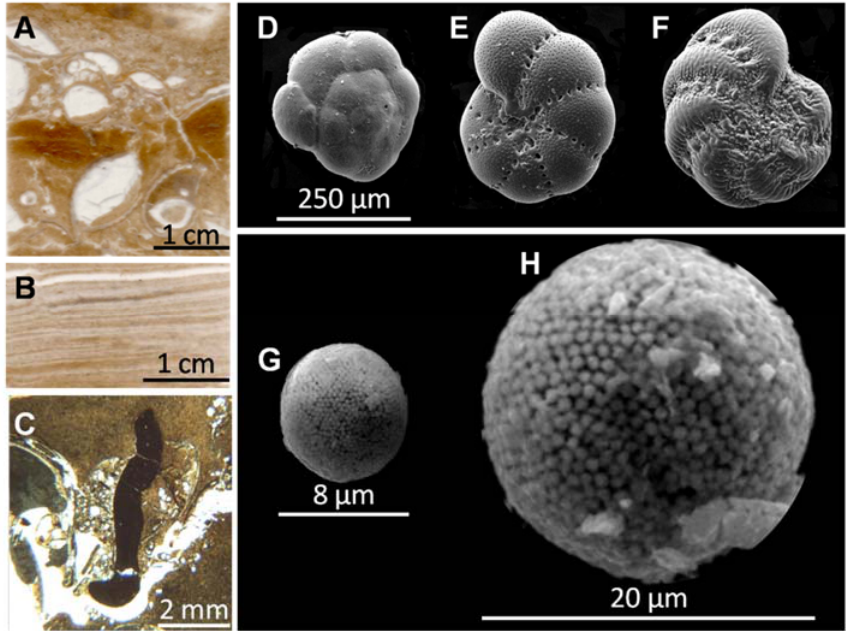
Figure 4. Illustrations of elements encountered in the studied cores. Sedimentary structures observed in thin section by optic microscope (see vertical positions in the cores in Figure 3): ( A ) tempestite at the top of Unit 8 in GC7; ( B ) laminations between 169 and 171 cm in GC7 (Unit 9) and ( C ) bioturbation between 145 and 146 cm in GC15 (Unit 6). Scanning electron microscopy (SEM) images of benthic foraminifera: ( D ) Ammonia spp. and ( E , F ) two different species of Elphidium spp. SEM images of framboidal pyrites: ( G ) between 1 and 5 cm and ( H ) between 28 and 30 cm in the GC15 core.